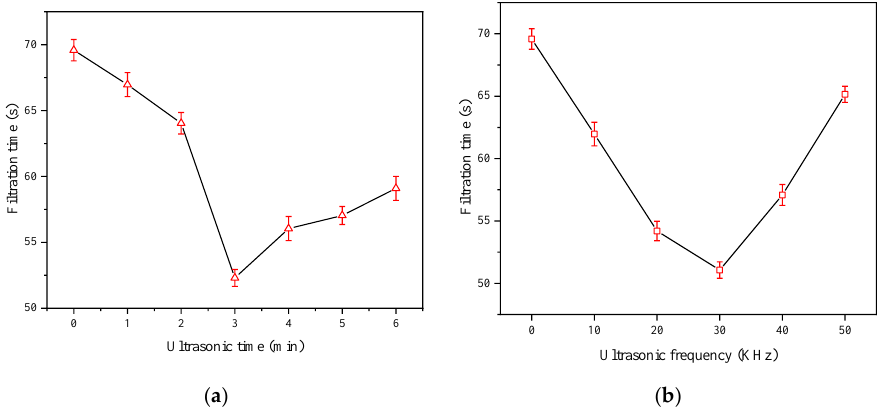
Figure 7. Effect of ultrasonic time ( a ) and ultrasonic frequency ( b ) on LRC slurry filtration time.